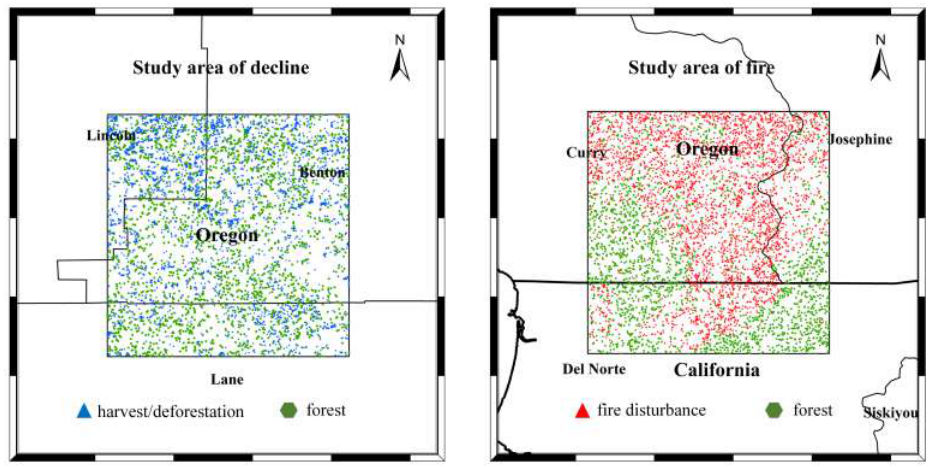
Figure 3. Two annotated areas with different types of forest disturbances. Harvest/deforestation disturbance samples are shown in left , while fire disturbance samples are shown in right